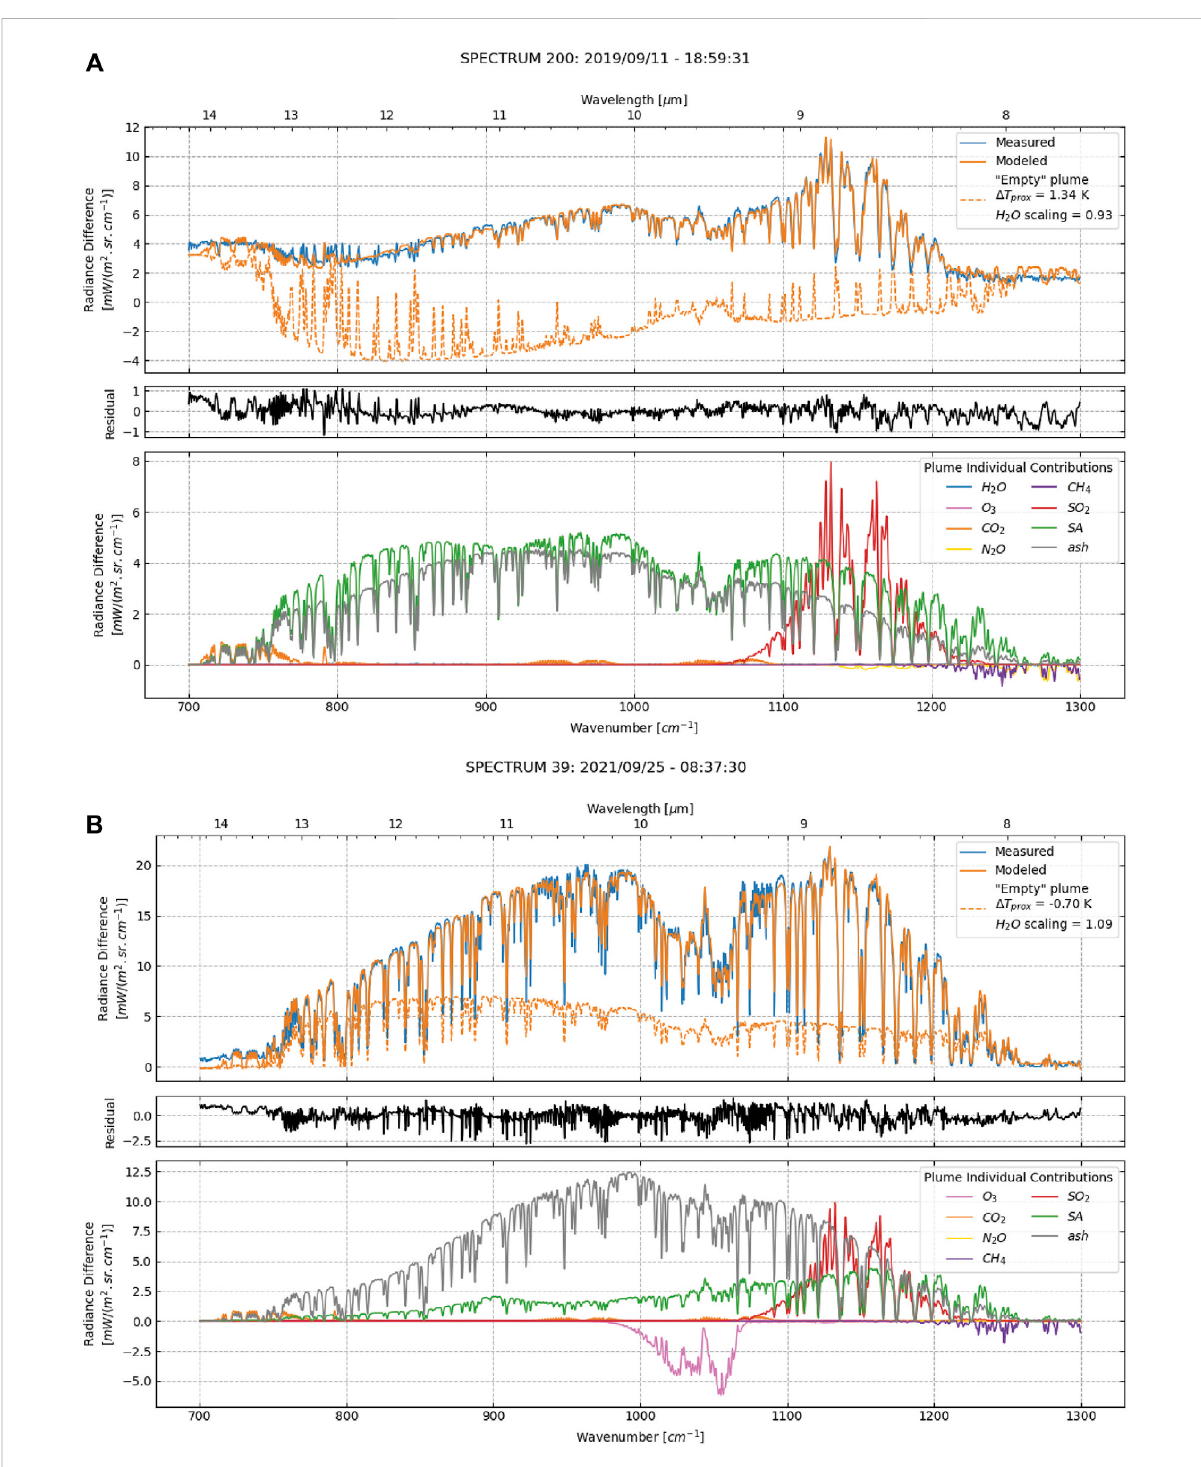
FIGURE 7 Example of fi t results for selected individual spectra. In each subpanel: the top plot shows the measured [blue] and modelled [orange] spectra, along with the expected radiance difference without a plume in the line of sight [dotted orange] based on best- fi t parameters for water vapour scaling and observer temperature; the middle plot shows the residual between modelled and measured spectra [black]; and the bottom plot shows the individual contribution of each plume species to the modelled spectrum (A) Plume spectrum with both ash and sulphate aerosol (SA) particulates, highlighting the differences in spectral shape between the two species, acquired on 11 September 2019 (B) Ash-rich plume spectrum acquired on 25 September 2021. Note the large O 3 adjustment needed to fi t the depth of the measured absorption